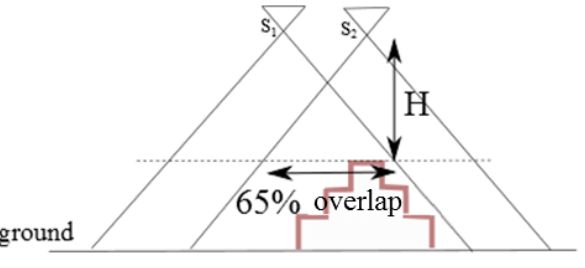
Figure 6. Flight height and overlap above relief